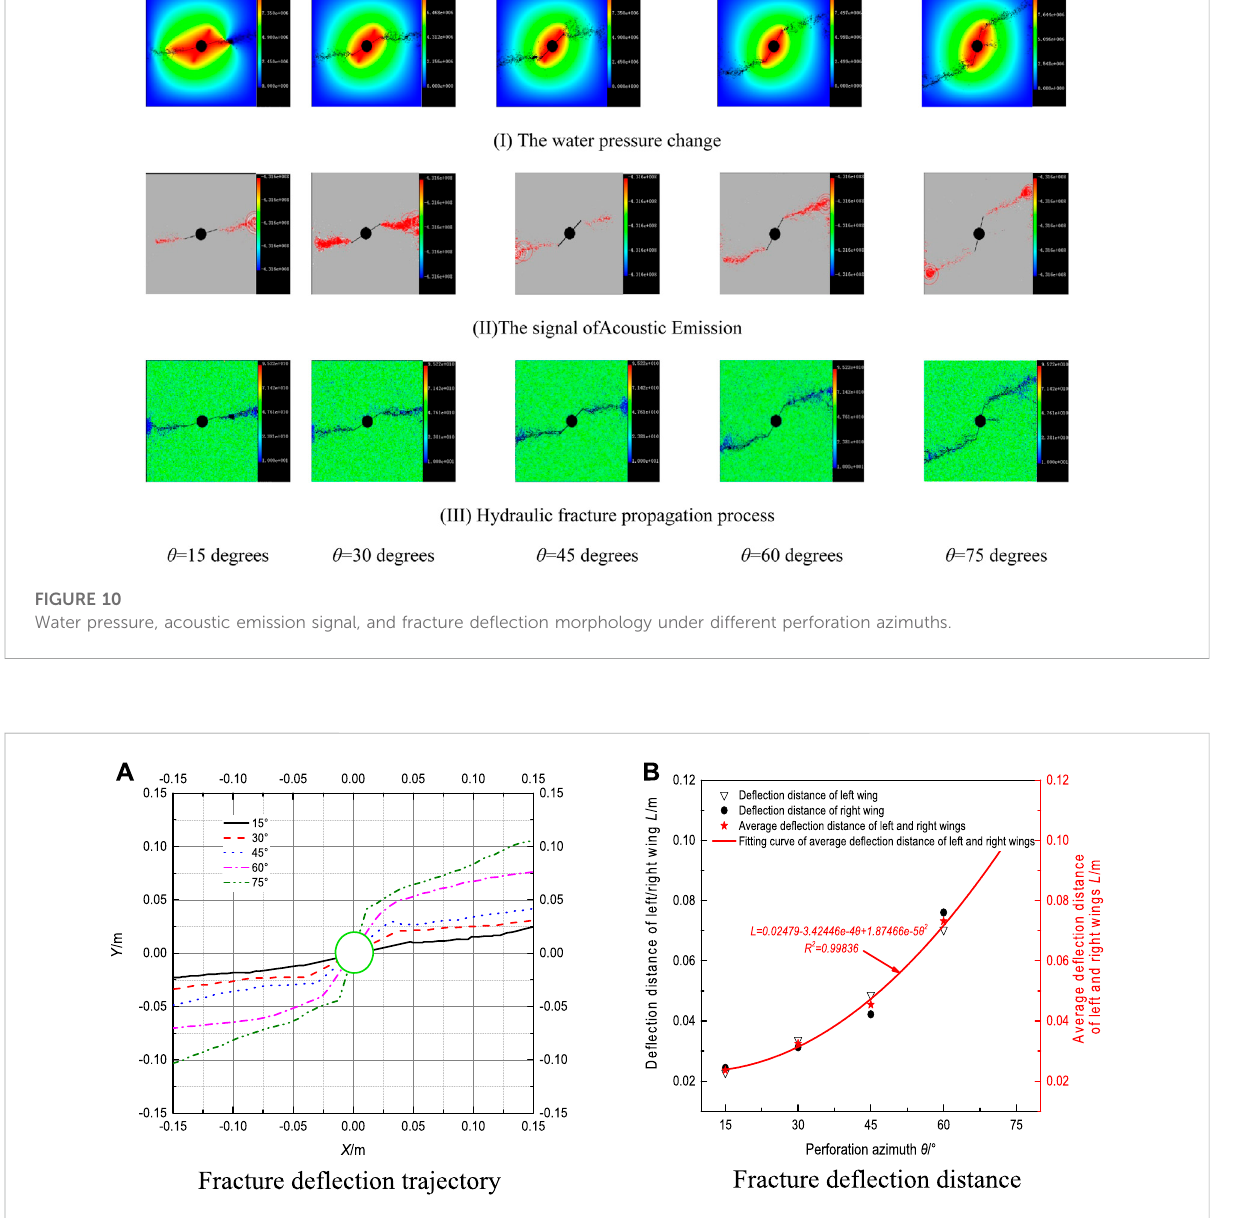
FIGURE 11 Hydraulic fractures ’ de fl ection trajectory and distance under different perforation azimuths.